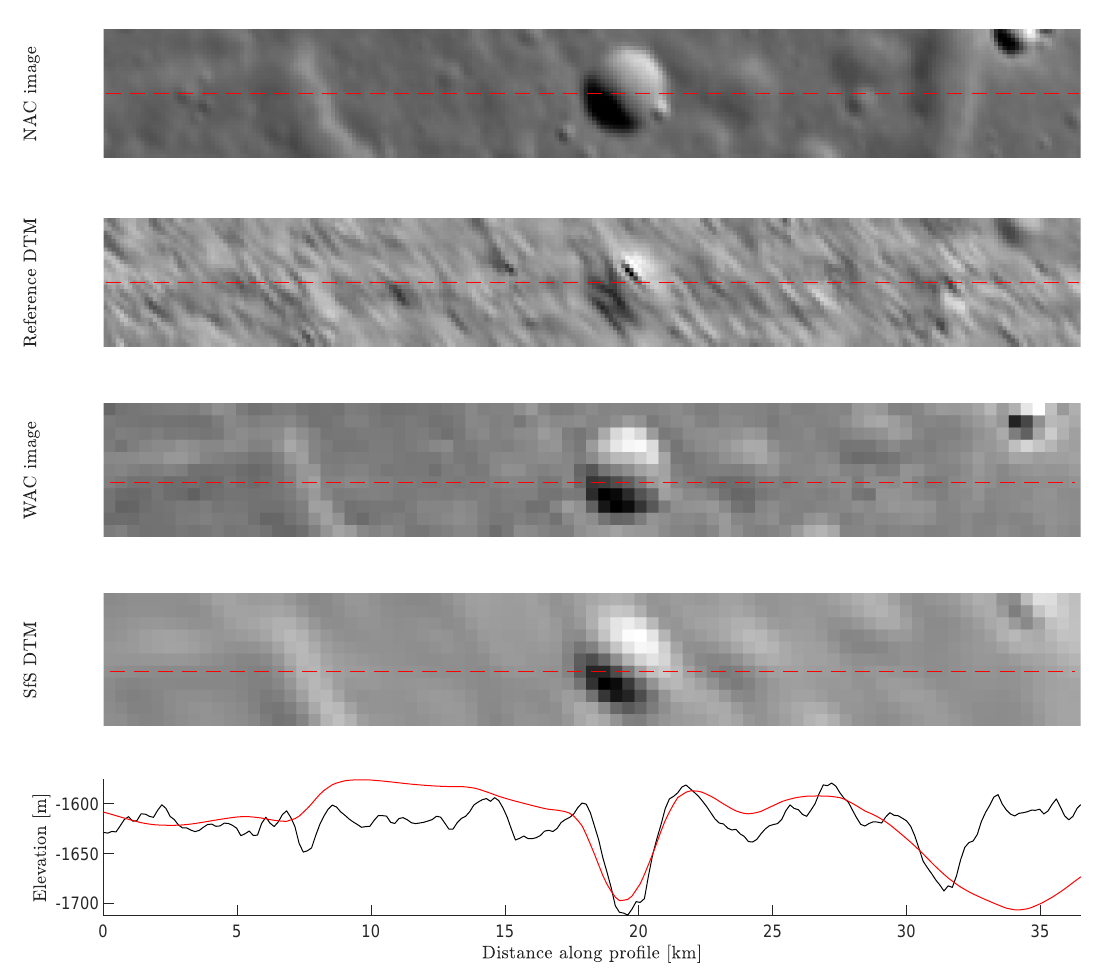
Figure 22. Sections of the DTMs in Figure 11. The DTMs are compared to the corresponding image parts. In the case of the stereo DTM, the original image is an orthophoto from NAC images [29], and, for the SfS DTM, it is the mosaic of WAC images. Below that, the elevation of the profile (red dashed lines) over the length of the section is shown. The SfS DTM is drawn in red and the stereo DTM in